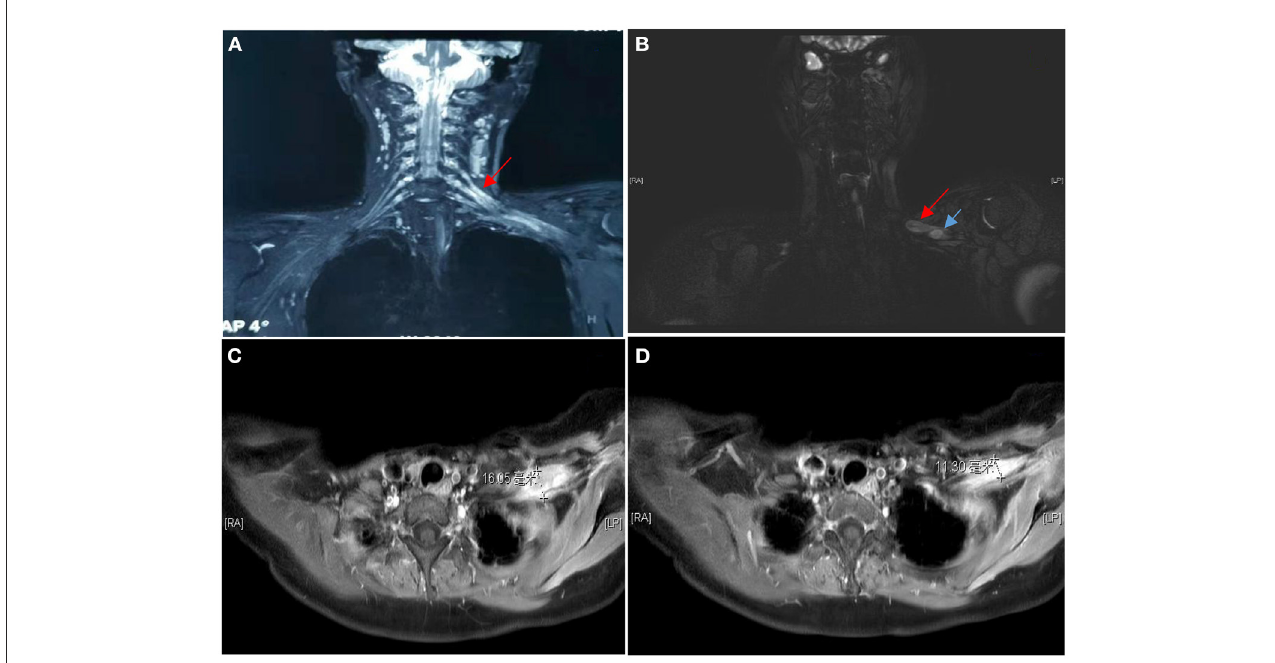
FIGURE1 MRI of the brachial plexus showed the C5/C6 roots, upper and middle trunks and all strands of the left brachial plexus were significantly swollen and thickened, with T2W high signal, the right brachial plexus had good continuity, with no clear thickening and no signal enhancement (A) . MRI showed multiple nodules within the brachial plexus in the left subclavian region (B) , the two that could be distinguished were ∼ 16mm (C) and 11mm (D) in diameter